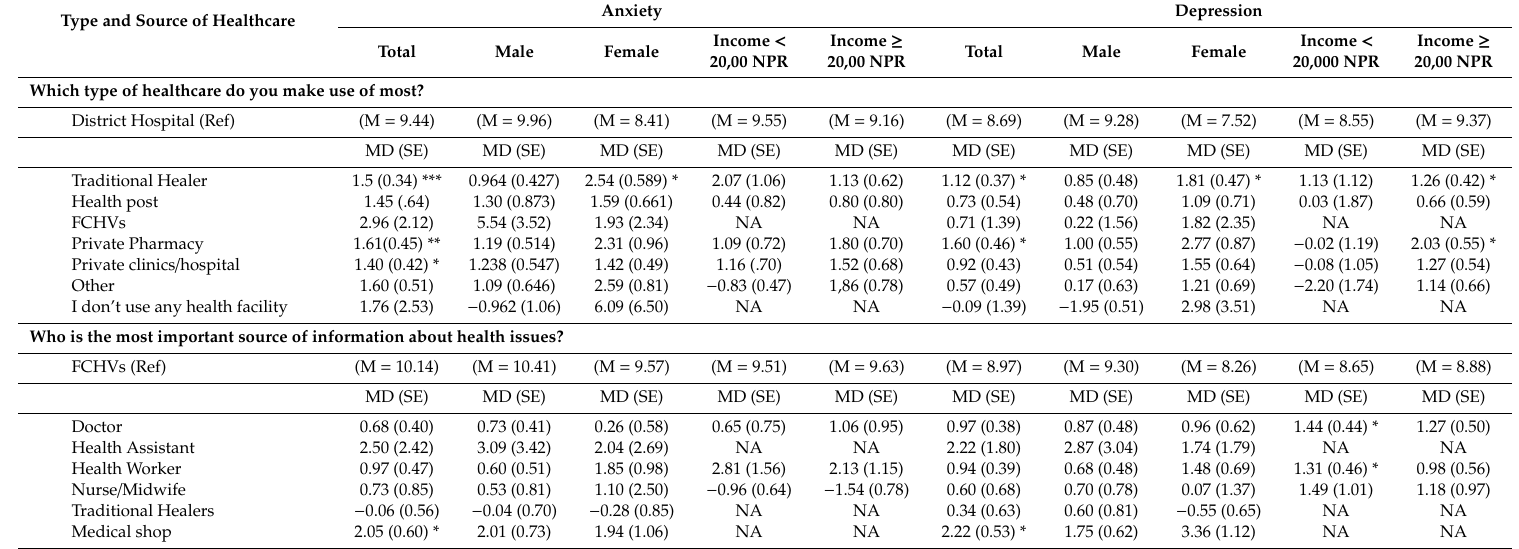
Table 5. Within group comparisons by type and source of